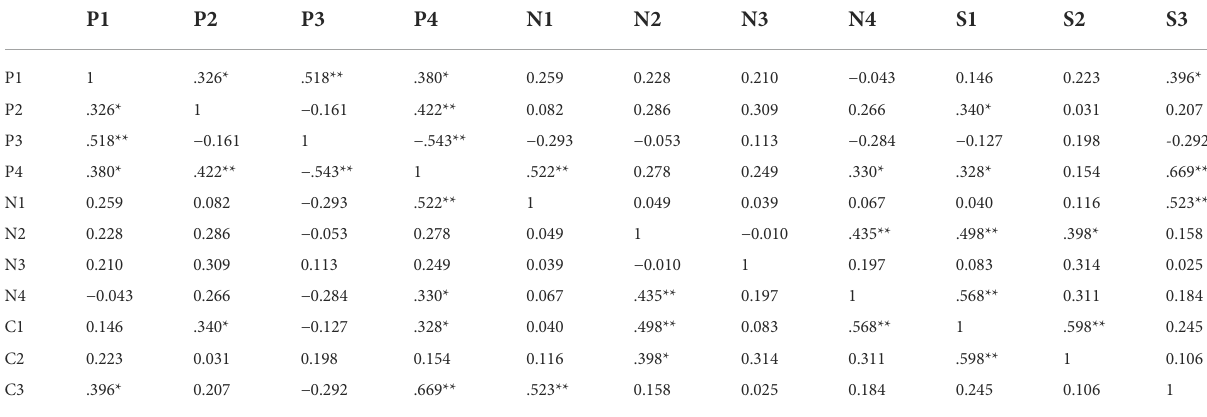
TABLE 3 Correlation between the